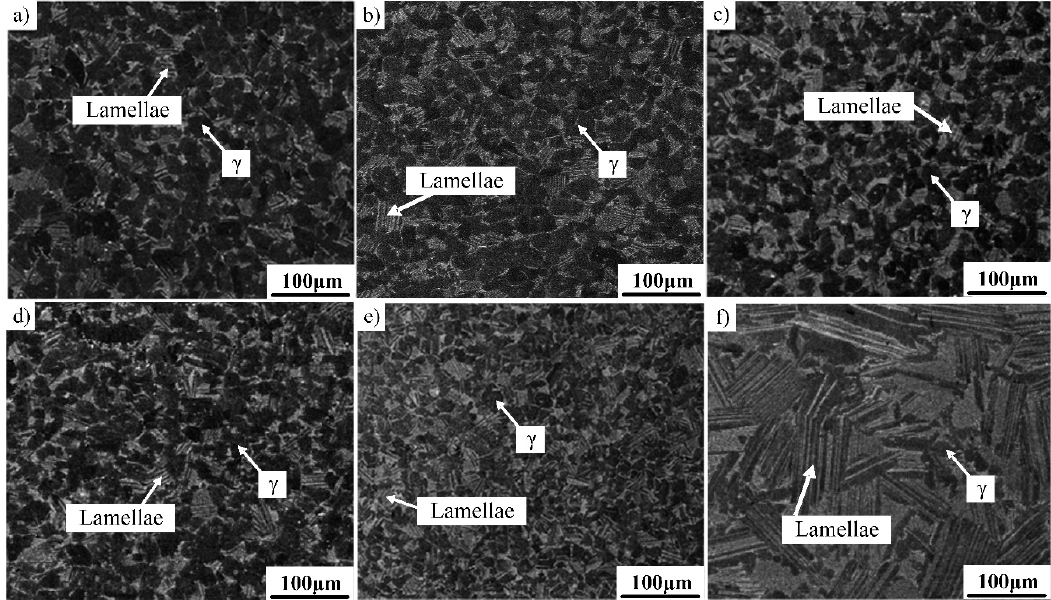
Figure 4. DP microstructure of the as-forged Ti–43Al–2Cr–2Mn–0.2Y alloy in different heat treatment conditions. ( a ) 1230 ◦ C / 4 h, ( b ) 1240 ◦ C / 4 h, ( c ) 1250 ◦ C / 4 h, ( d ) 1260 ◦ C / 4 h, ( e ) 1270 ◦ C / 4 h, ( f ) 1320 ◦ conditions. ( a ) 1230 °C/4 h, ( b ) 1240 °C/4 h, ( c ) 1250 °C/4 h, ( d ) 1260 °C/4 h, ( e ) 1270 °C/4 h, ( f ) 1320 °C /10 min+1260 °C/4 h.